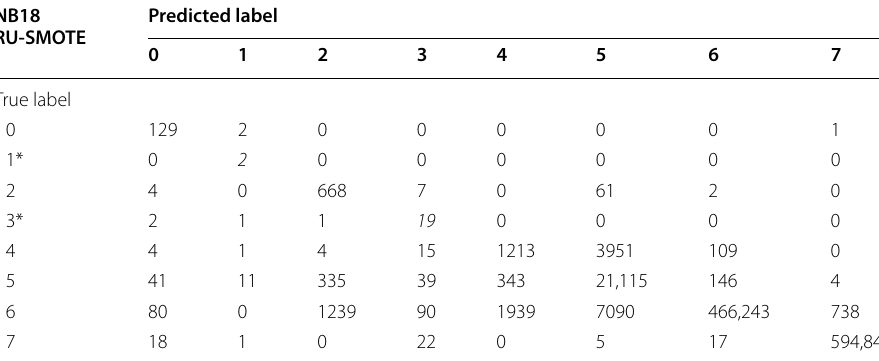
Table 35 Confusion matrix: NB18 RU-SMOTE NB18 RU‑SMOTE